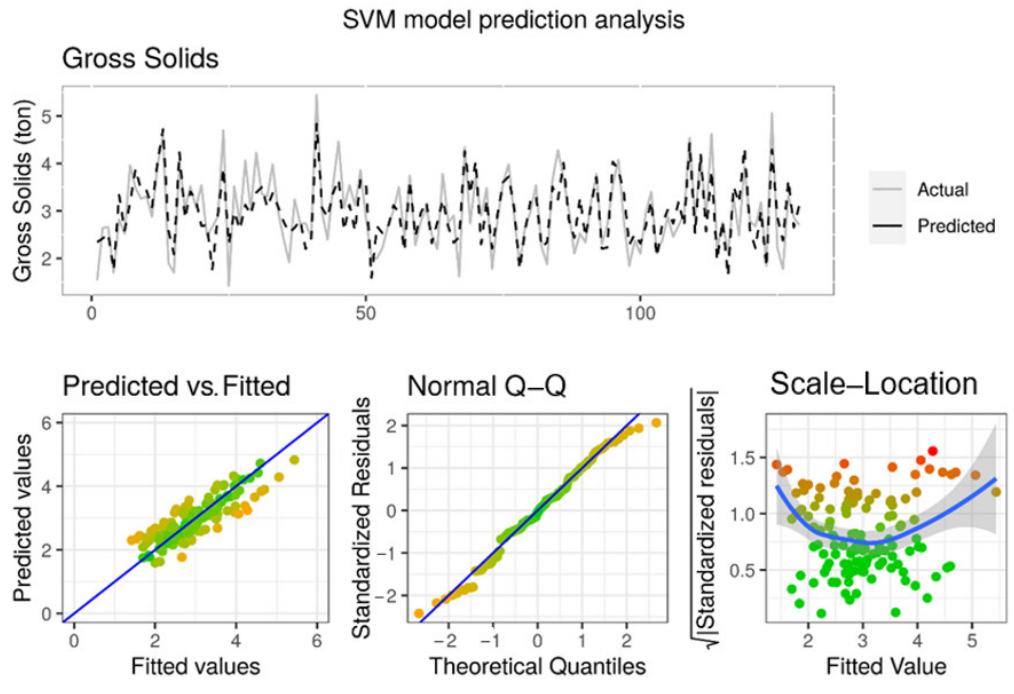
Figure 5. Analysis of results in the training phase.